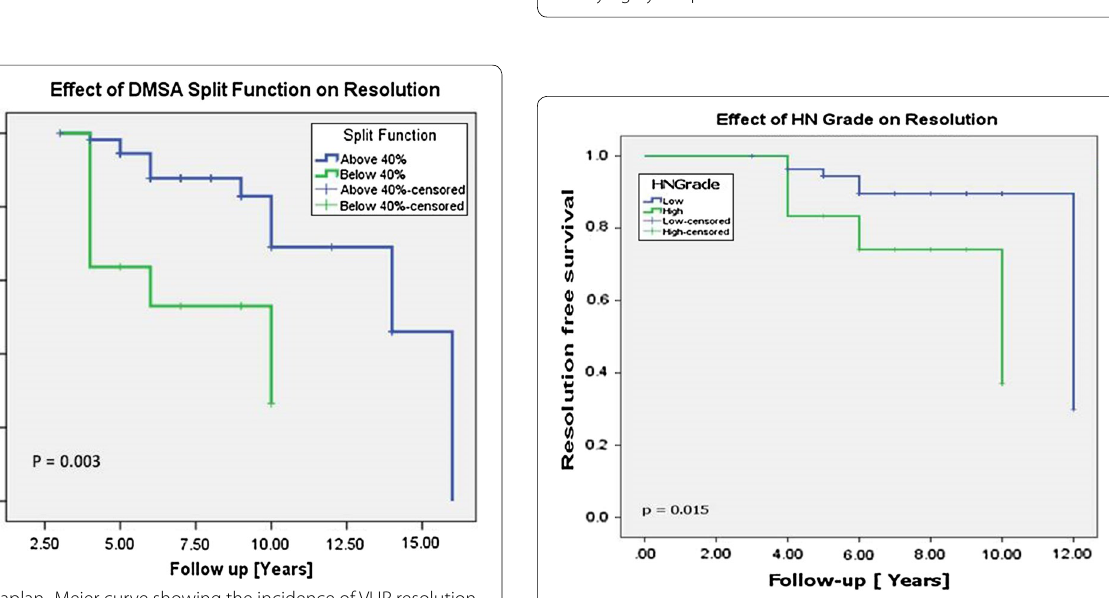
Fig. 3 Kaplan–Meier curve showing the incidence of VUR resolution stratifying by the presence of associated HN